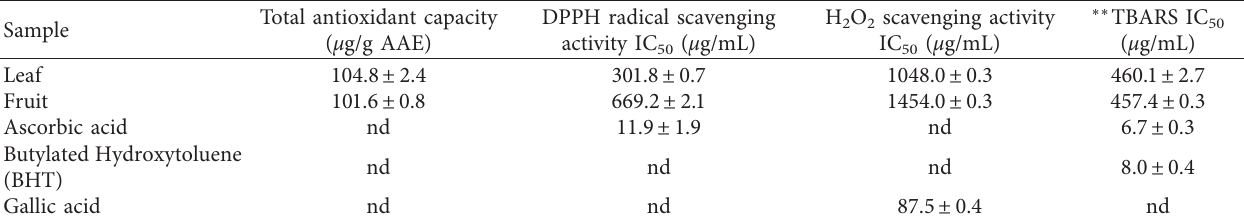
Table 6: Antioxidant activities of leaf and fruit essential oils of Chrysophyllum albidum as determined from different assays.